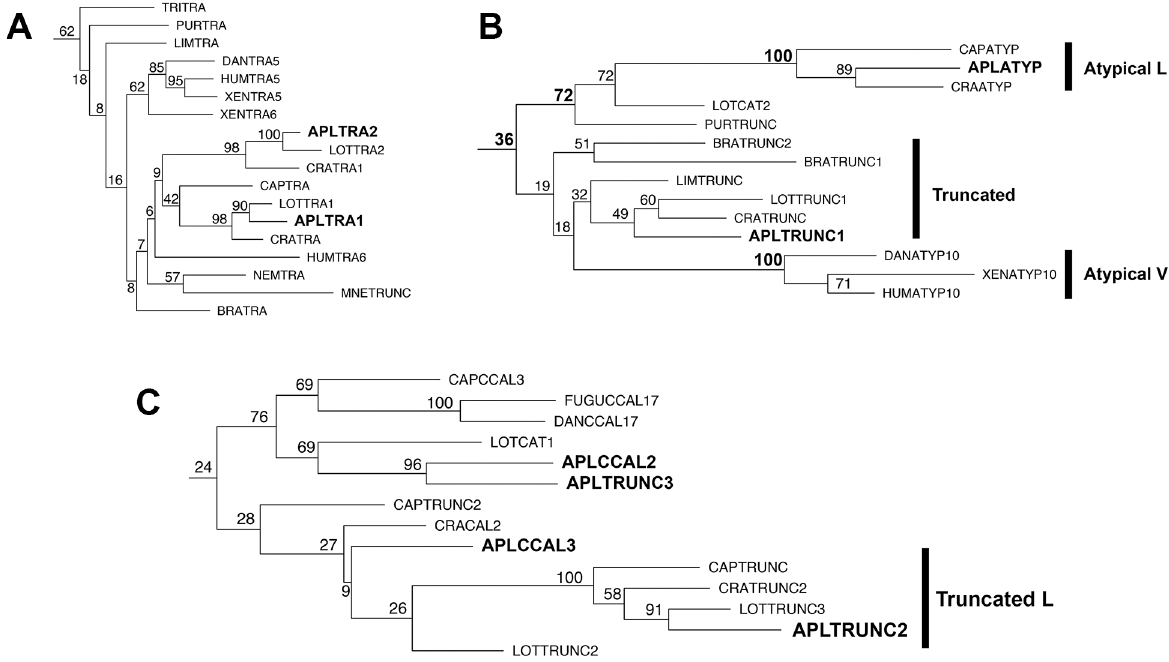
Fig 3. Phylogeny of Tra, Atypical and Truncated families. Speciesabbreviationsand their phylogenetic classificationand common name are detailedin Table 1. All reference numbers for sequencesare in S1 Table. The analysisis describedin the methods (the plot is from the RAxML analysis). Aplysia calpainsare in larger font and boldedas are bootstrapnumbersreferred to in the text that define families. When multiple families are present, the families are definedby the lines and the family name on the right. (A) Tra family, (B) Atypical and Truncatedfamilies (C) Truncatedfamily L and associatedTruncatedand Classicalcalpains.